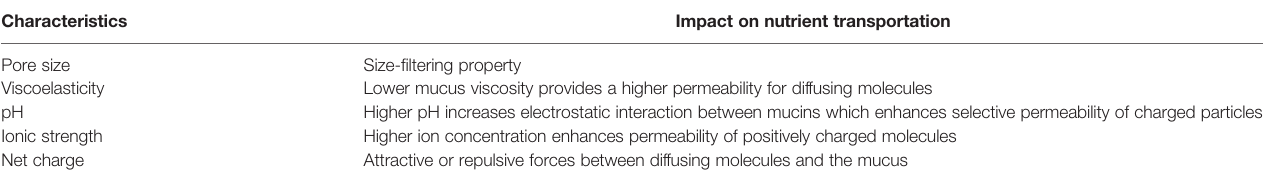
TABLE 4 | Physiochemical characteristics of mucus layer affect nutrient transportation a